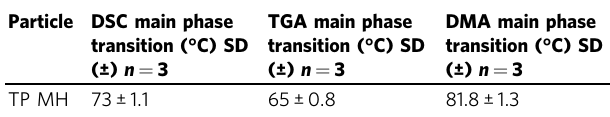
Table 2 Standard deviation associated with the standard thermal methods used in this study.